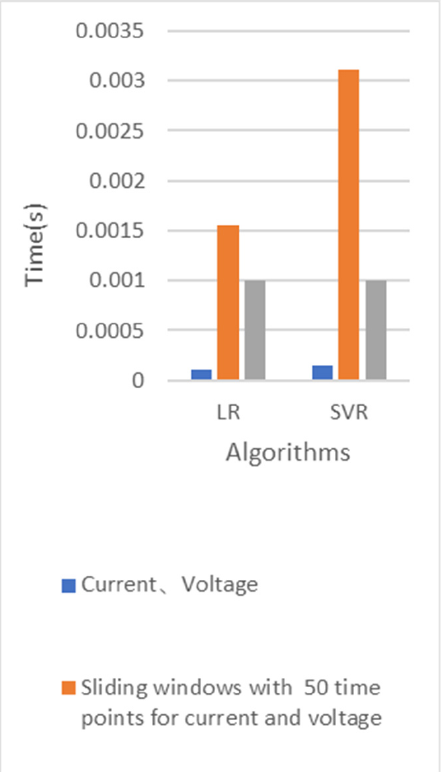
Figure 9. Total time consumption comparison of integrated algorithms (time within 0.003 s). It can be observed that XGBoost, Random Forest, Linear Regression, and SVR pre- sent low time consumption. The time consumption of the Kalman filter framework algo-